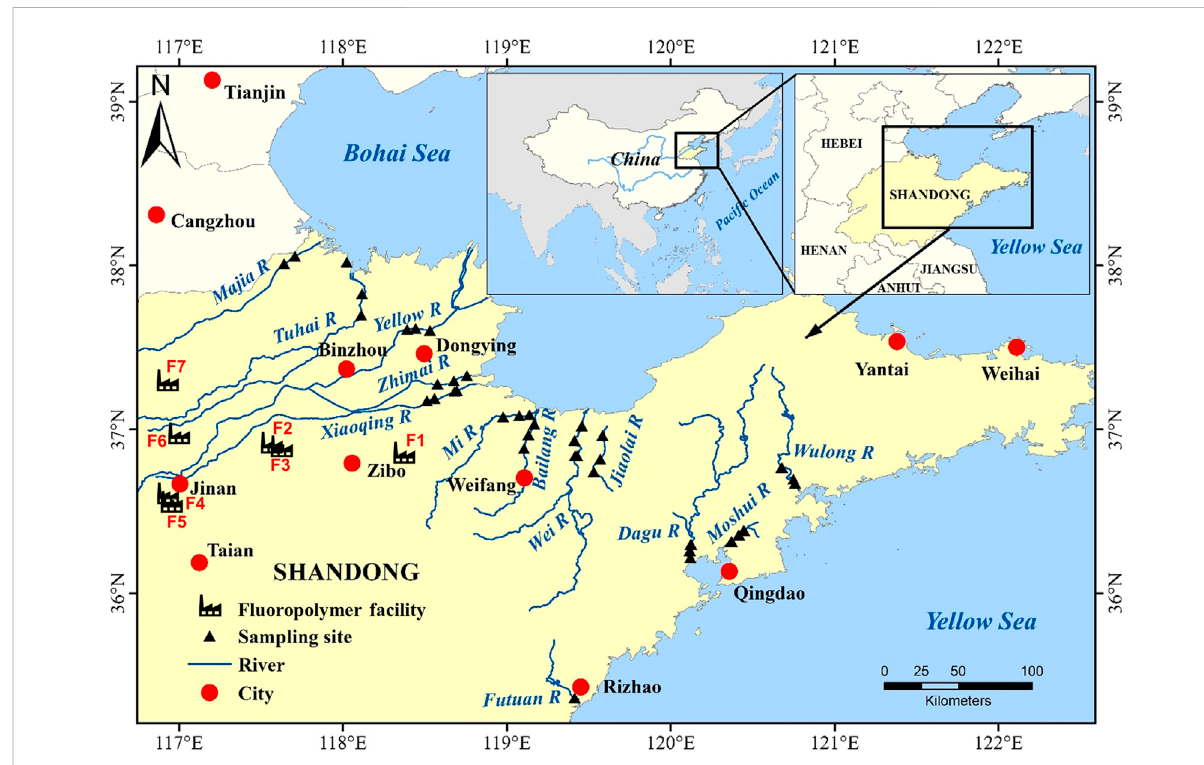
FIGURE 1 Illustration of the sampling sites on the coastal rivers of Shandong, China (only the outmost eastern section of the Yellow River is outlined) and locations of fl uoropolymer facilities (F1 – F7) achieved from the literature.